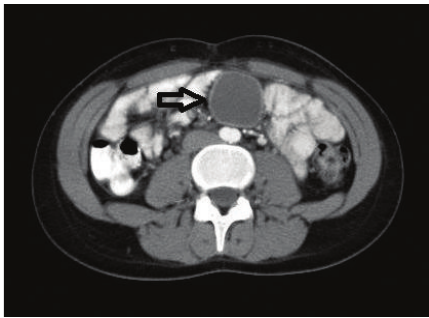
Figure 1: Tomographic view of the urachal cyst (arrow).